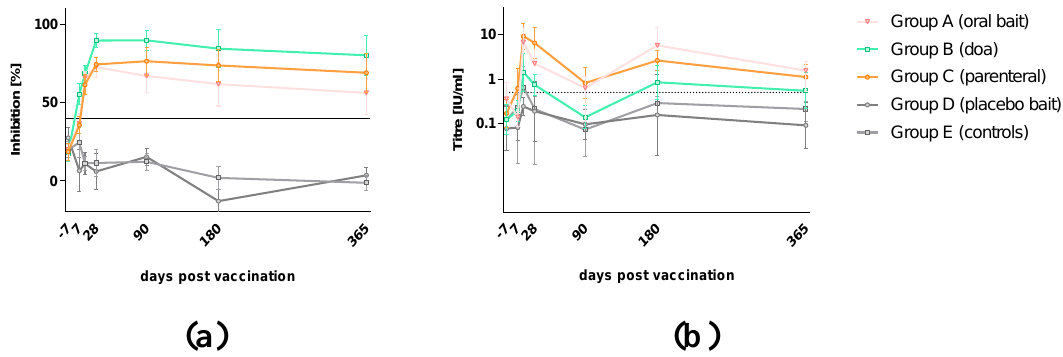
Figure 2. Antibody response in local Thai dogs after oral rabies vaccination (Group A and B), parenteral vaccination (Group C) using SPBN GASGAS and a commercial inactivated vaccine, respectively, as well as after placebo baiting (Group D) and left untreated (Group E). Serology results of all treatment groups are presented as mean percent inhibition and geometric mean titer with standard deviation as measured by ELISA ( a ) and Rapid Fluorescent Focus Inhibition Test (RFFIT) ( b ),